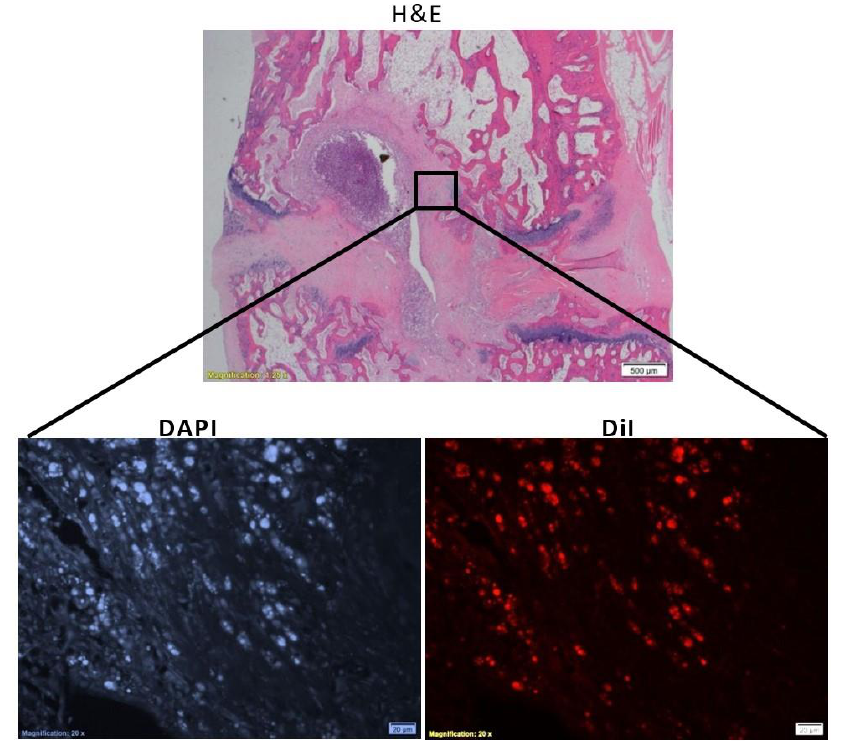
Dead Figure 5. Viability of hBM-MSCs encapsulated in alginate beads after seeded in GAG-analogue hy- drogel. Constructs comprising GAG analogue (1.5%) and encapsulated cells (2 × 10 6 cells/mL beads) were incubated for six weeks and stained with a LIVE/DEAD ® assay kit. hBM-MSC-loaded beads were imaged using bright-field and fluorescence microscopy. The scale bar is 200 µm. 3.5. In Vivo Viability of Cell-Loaded Beads Transplanted into an Intervertebral Disc Model The capability of the construct (cell-loaded beads seeded in GAG analogue) to main- tain cell viability in vivo was further tested. To this aim, constructs were implanted in an